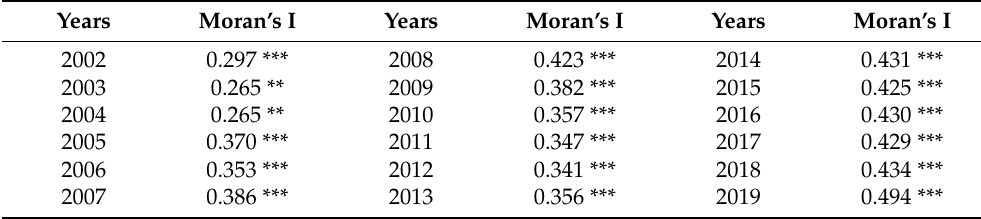
Table 3. Moran’s I value of ANSP in Gongyi